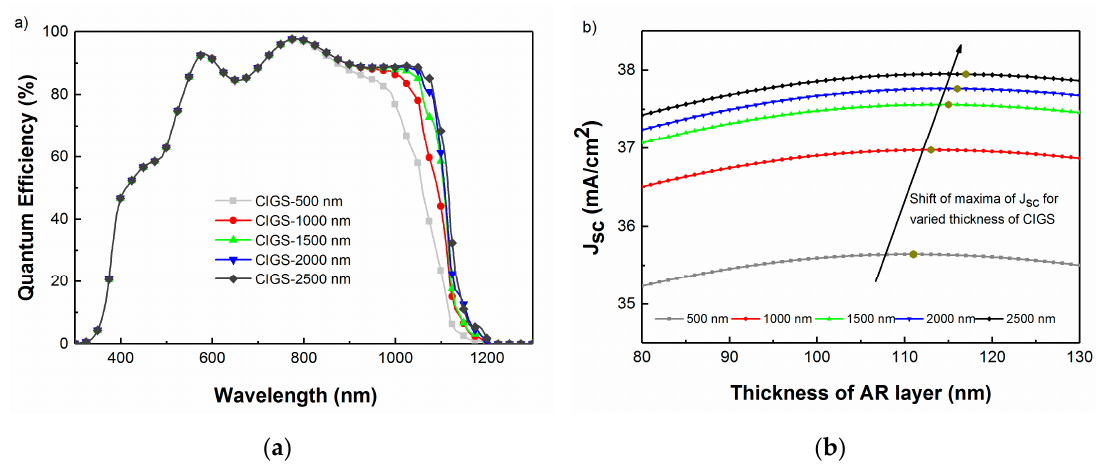
Figure 7. ( a ) Simulated QE with varied CIGS layer thickness and a fixed 111 nm thick MgF 2 layer. ( b ) Simulated J SC as a function of MgF 2 thickness, for varied CIGS layer thickness.